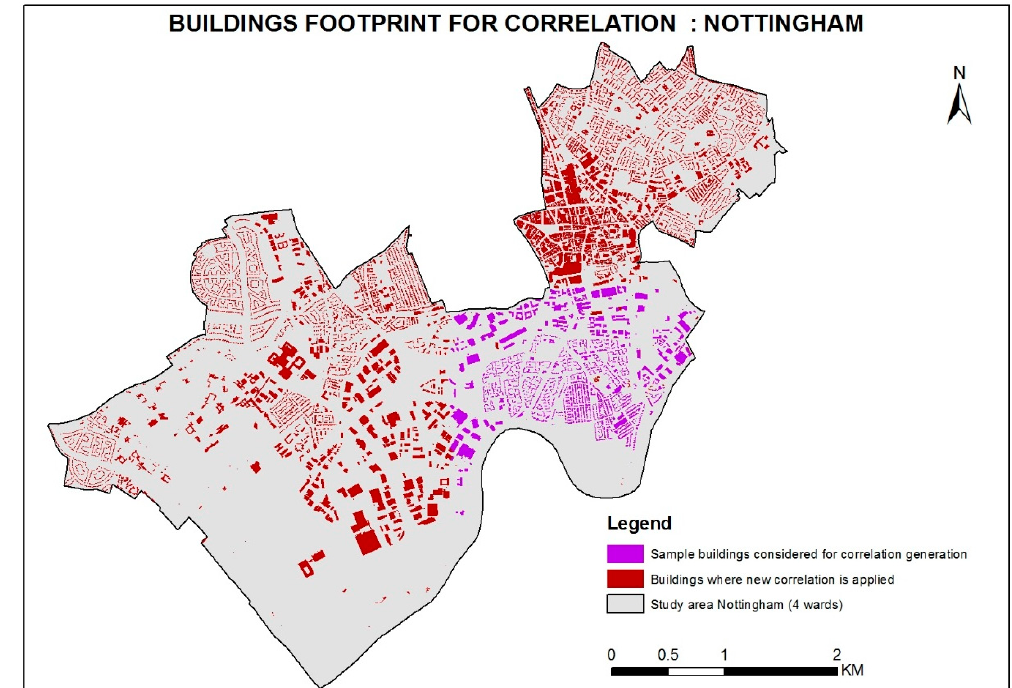
Figure 3. Sample buildings considered for 3D generation and correlation, Nottingham, UK .